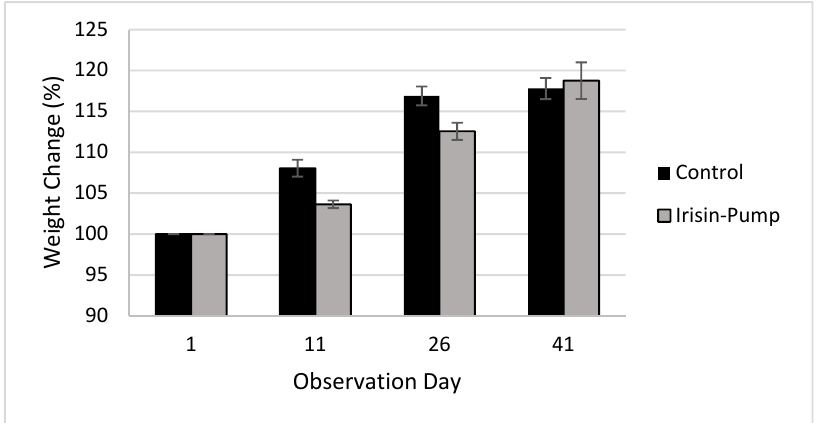
Figure 1. Percent weight change in Sprague Dawley rats after chronic administration of irisin via an osmotic pump.